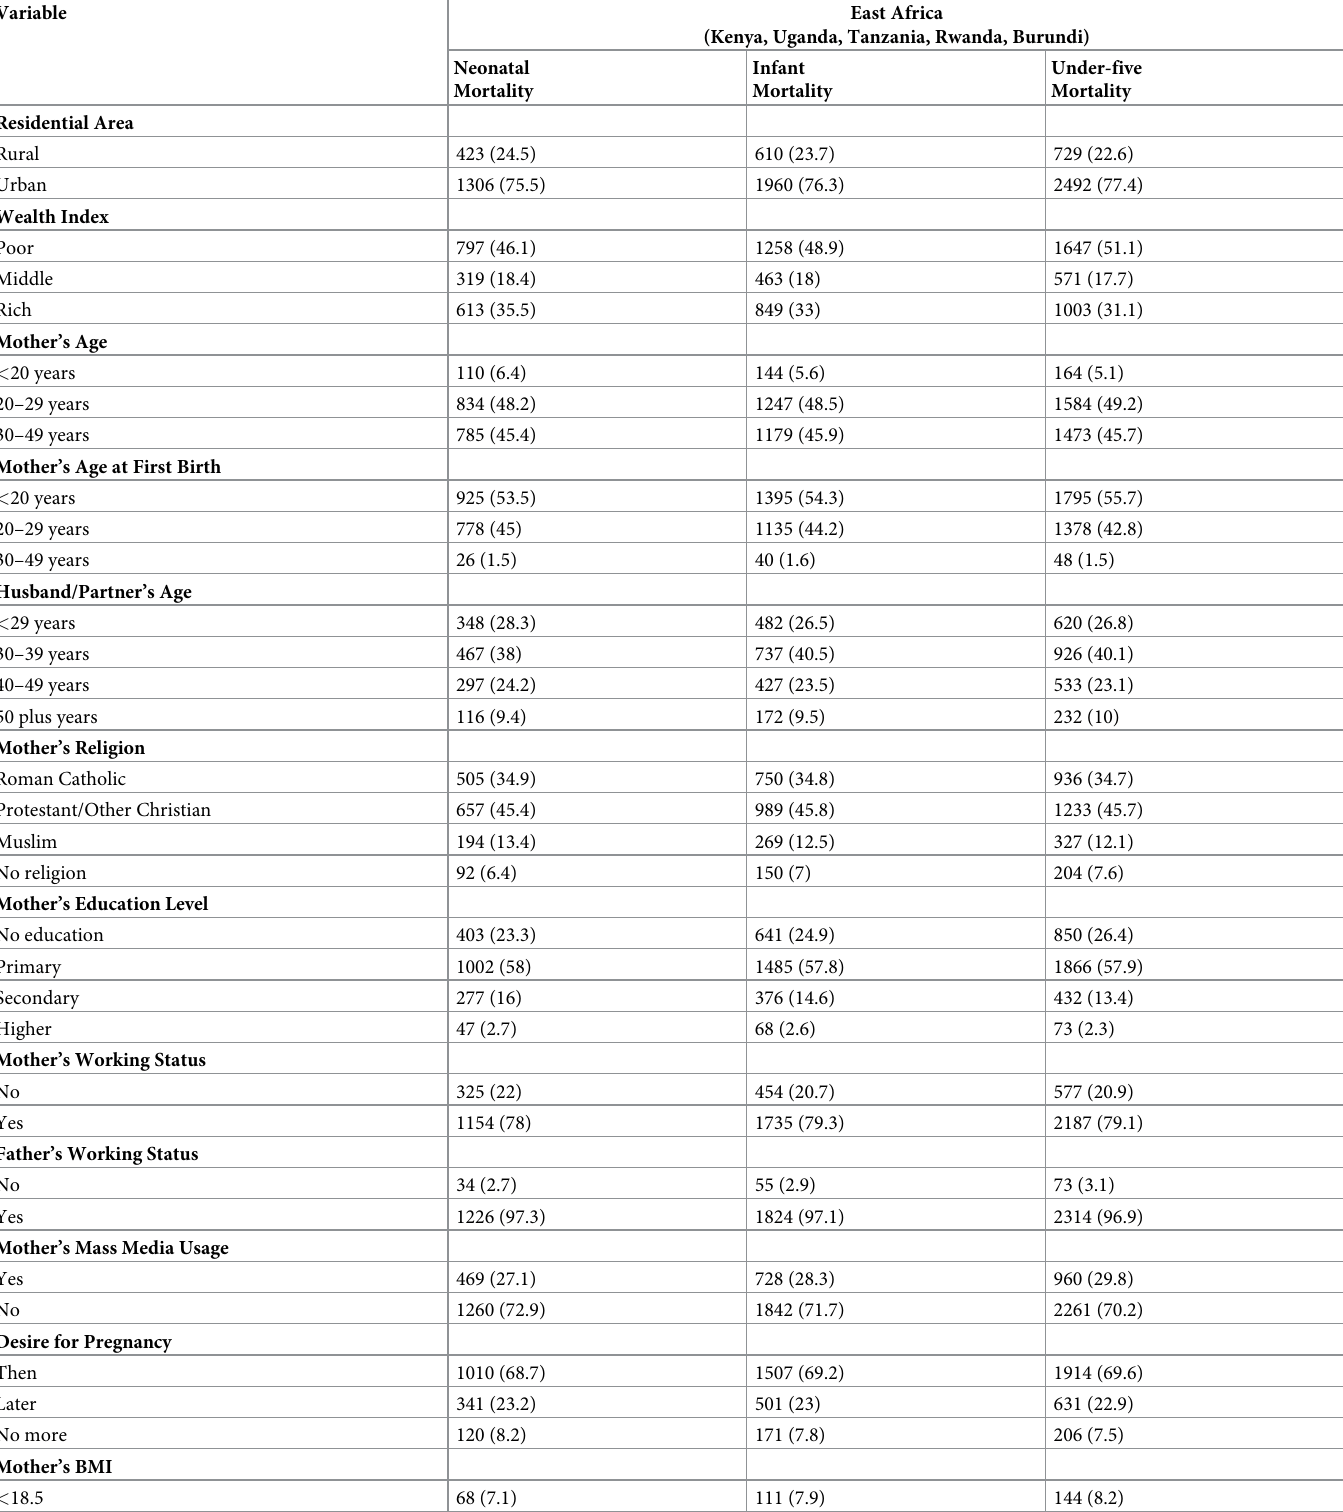
Table 3. Characteristics of respondents used in the analysis of neonatal, infant, and under-five mortality in East